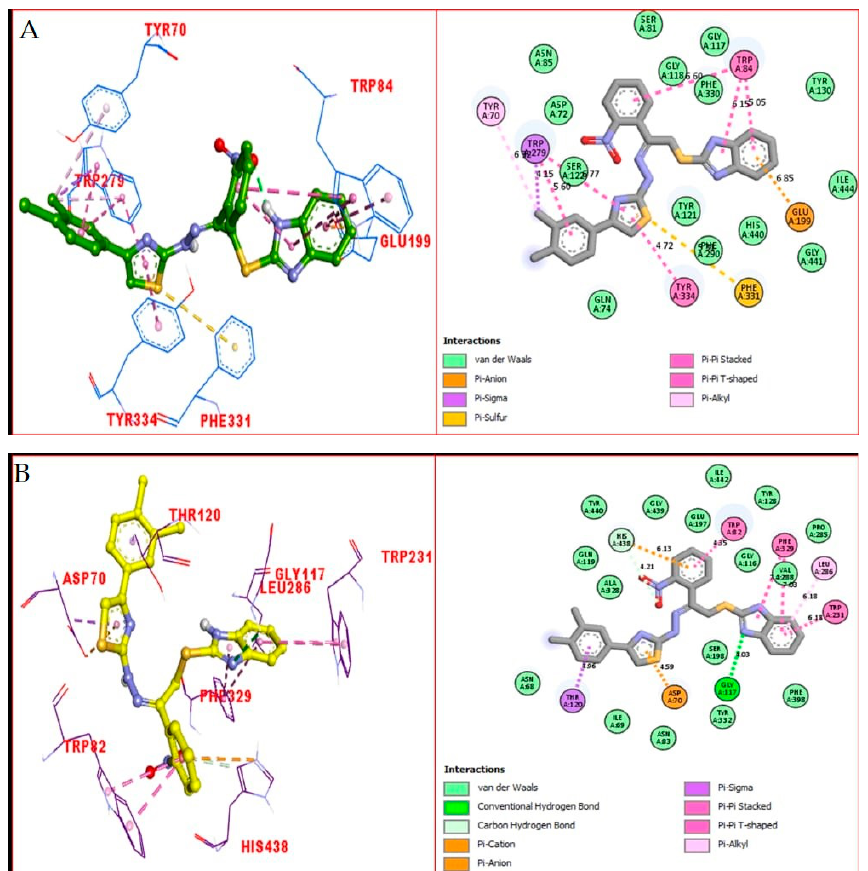
Figure 12. The PLI profile of the third most potent analogue ( 15 ):( A ) analogue 15 against acetylcholinesterase (AChE);( B ) analogue 15 against butyrylcholinesterase (BuChE) enzymes. The calculated binding energies, number of hydrogen bonds, and number of closest residues surrounding the selected docked analogues into the active sites of both AChE and BuChE enzymes are shown in Table 2.